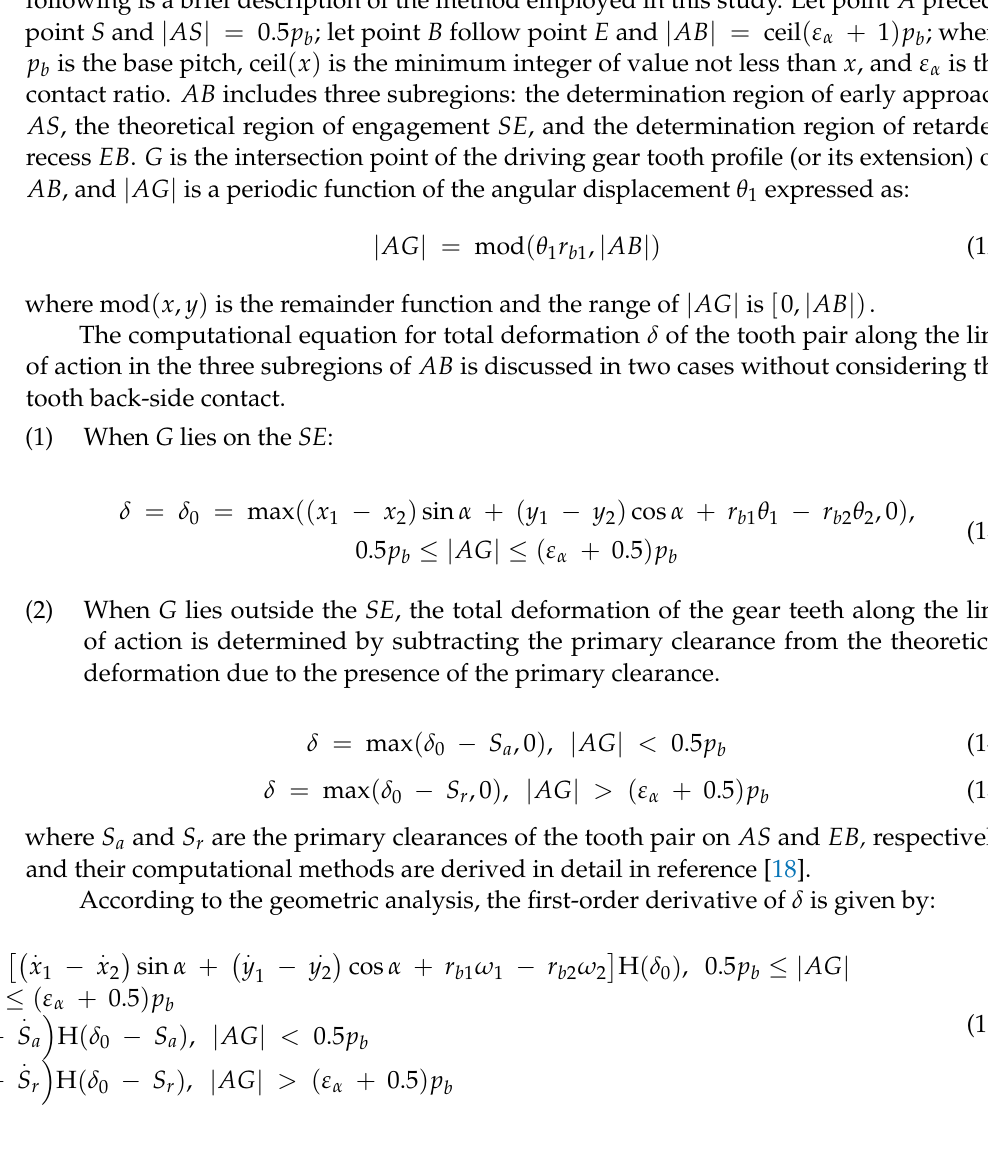
Figure 2. Meshing analysis of spur